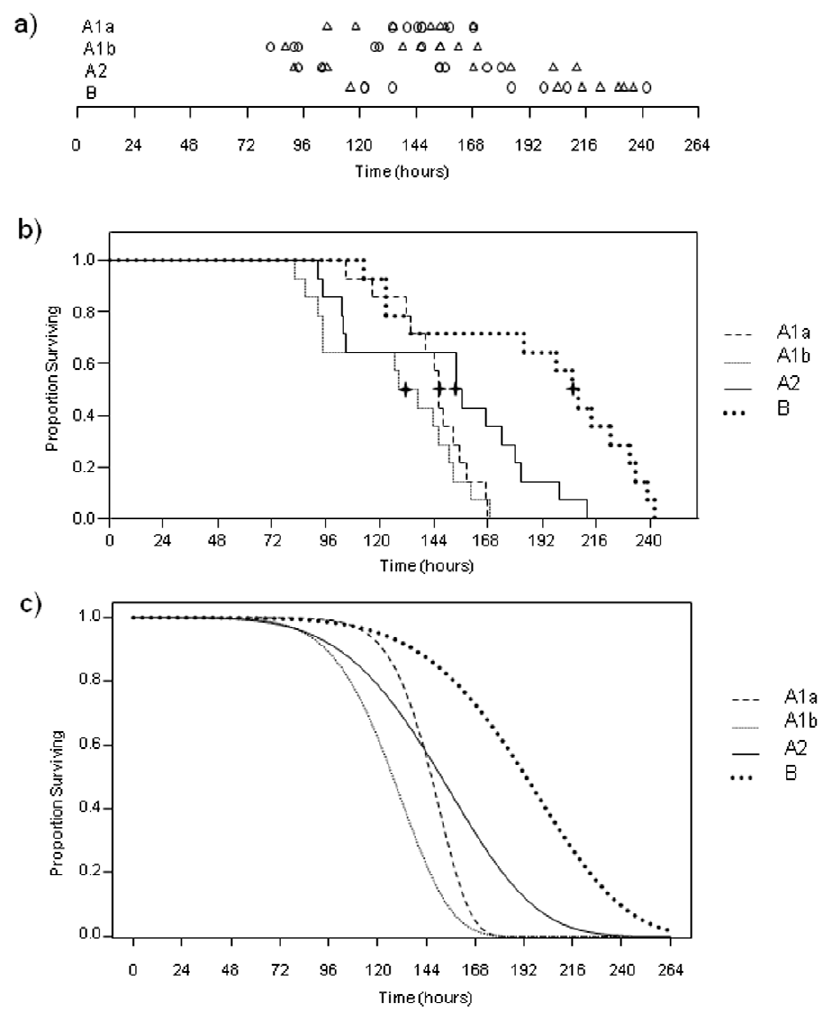
Figure 2. Survival curves of naı¨ve mice following challenge with F.tularensis A1a, A1b, A2 and type B. C57BL/6J mice (n=14/group; n=7/strain) were challenged intradermally with 10–20 CFU of F. tularensis A1a (strains OK01-2528 and MO02-4195), A1b (strains MD00-2970 and MA00-2987), A2 (strains WY96-3418 and NM99-1823) and type B (strains KY99-3387 and MI00-1730), and survival was monitored over time. A ) Time of death for n=14 mice per F. tularensis group (A1a, A1b, A2 and type B). Circles represent mice infected in round 1(n=7) and triangles represent mice infected in round 2 (n=7). B ) Step-down survival curves for proportion of mice surviving over time (hours). Data shown is from round 1 and round 2 for A1a, A1b, A2 and type B data. Median times of death are noted as a bold cross. C ) Fitted survival curves for proportion of mice surviving over time (hours) using a Weibull distribution for combined (n=14 mice/group) round 1 and round 2 A1a, A1b, A2 and type B data.